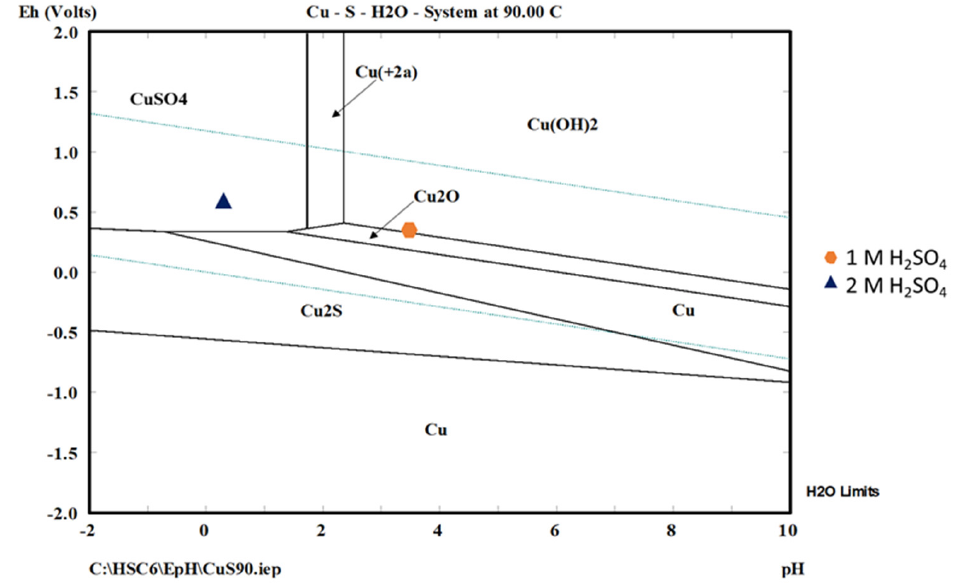
Figure 5. Pourbaix diagram for the Cu–S–H 2 O system at [Cu] = 0.95 M, 90 °C, and 0.55 MPa.